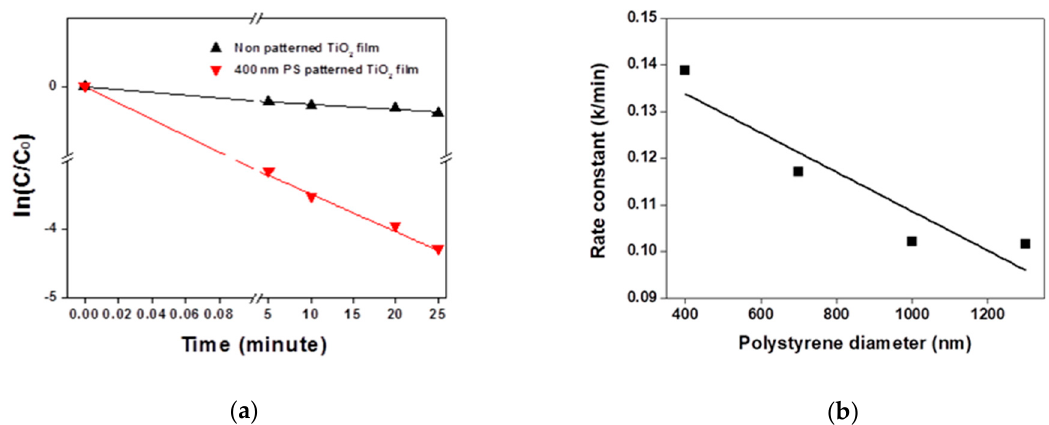
Figure 7. ( a ) Effect of initial MG concentration on the removal efficiency: the plot of ln(C/C 0 ) versus irradiation time for the nonpatterned TiO 2 film and the 400 nm PS-patterned TiO 2 film for 25 min. ( b ) Variation of rate constant with PS diameter. The perfect linearity indicates the first-order kinetics with the first-order rate constant (k 1 / min), but the experimental data have deviations, suggesting a pseudofirst-order rate constants (k obs /min).